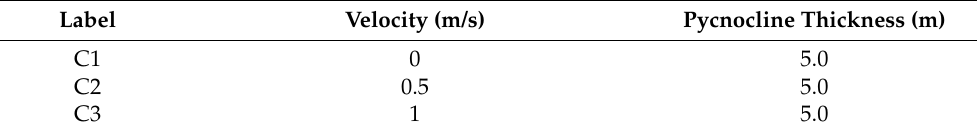
Table 5. Three cases of the submarine against ISWs with different velocity.